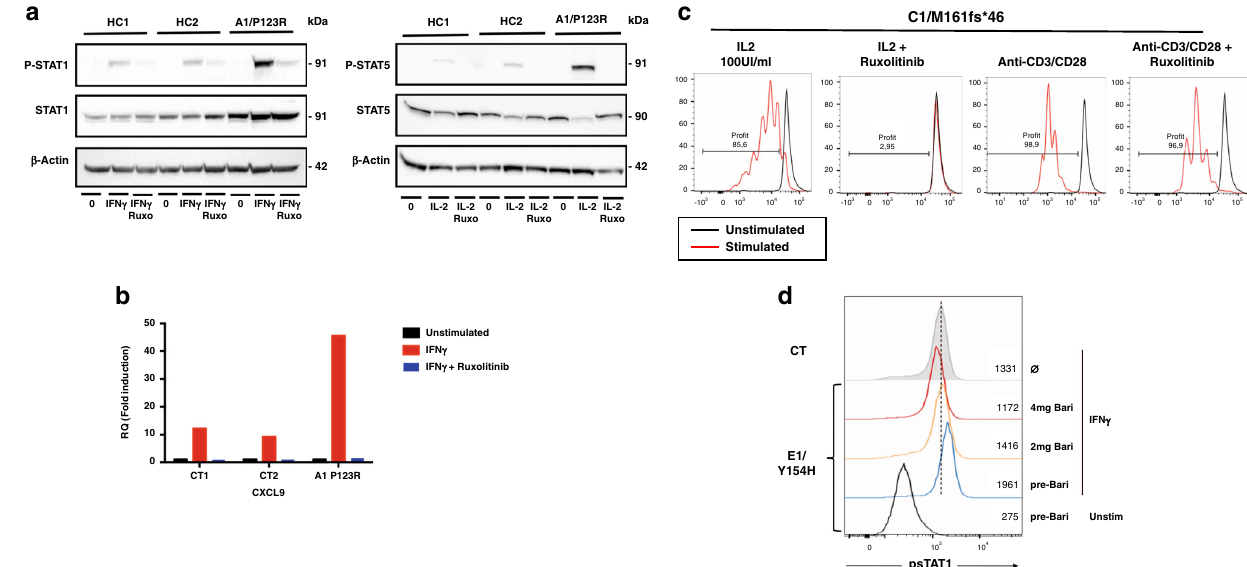
Fig. 5 In vitro and ex vivo ef fi cacy of JAK1/JAK2 inhibition. a EBV-B cells from HCs and from patient A1 were stimulated with IFN- γ (10 3 IU/ml for 1 h, left) and IL-2 (10 4 IU/ml for 2 h, right) in the presence or absence of ruxolitinib (Ruxo). Lysates were incubated with the indicated anti-P-STAT and anti- STAT antibodies, or anti-actin antibodies as a loading control. Data are representative of two independent experiments. b EBV-B cells from controls (CT) and from patient A1 were preincubated or not with ruxolitinib for 1 h, and stimulated for 6 h with IFN- γ . mRNA expression of the STAT1-regulated gene CXCL9 was determined in a quantitative RT-PCR assay. Results represent the fold-increased expression between stimulated and unstimulated states and are normalized to endogeneous GAPDH. Experiment performed once. c Effect of in vitro treatment with ruxolitinib on T-cell proliferation. T-cell blasts from patient C1 were stimulated with IL-2 (100 IU/ml) or anti-CD3/CD28 beads, in the presence or absence of ruxolitinib. The panel shows the proliferation of all T cells (CD3 + ). Data are representative of two independent experiments with cells from fi ve patients (A1, A2, B1, B2, and C1). d Primary monocytes from healthy control (CT, fi lled line) and E1 before (blue line) and under treatment by 2 mg (orange line) or 4 mg (red line) of baricitinib were stimulated with IFN- γ for 15 min and STAT1 phosphorylation (P-STAT1) was determined by intracelular fl ow